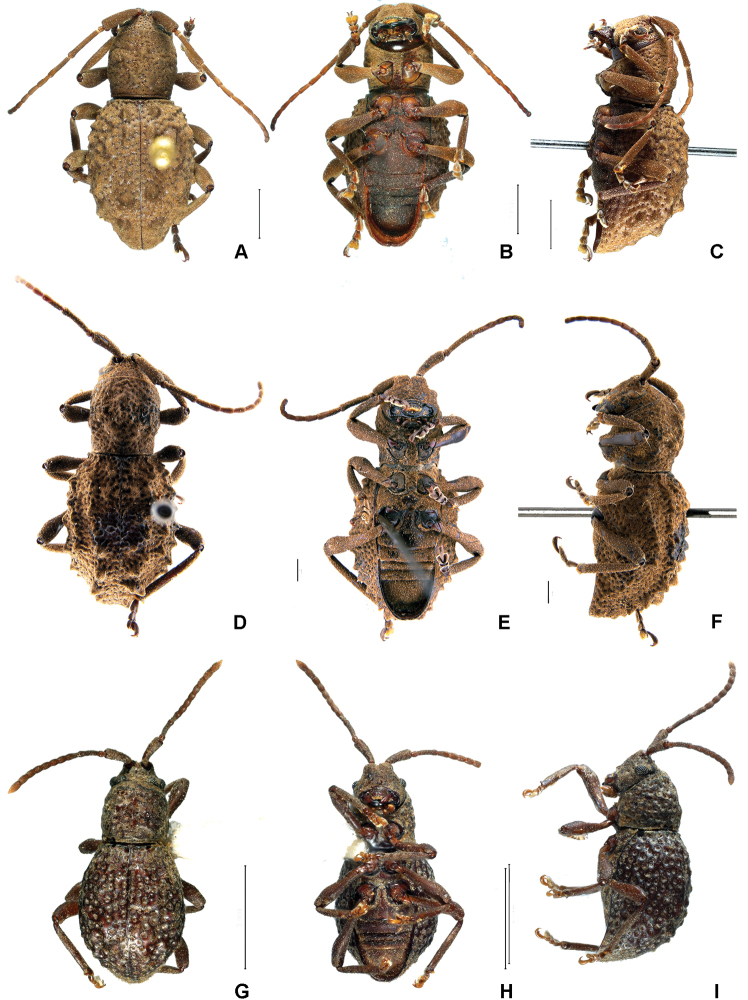
Dorsal, ventral and lateral view of three species of PhrynidiusA–CPhrynidius
cristinae sp. nov., holotype female D–FPhrynidius
armatus Linsley, allotype female G–IPhrynidius
diminutus sp. nov., holotype female. Scale bars: 2 mm (A–C, G–I), 1 mm (D–F).